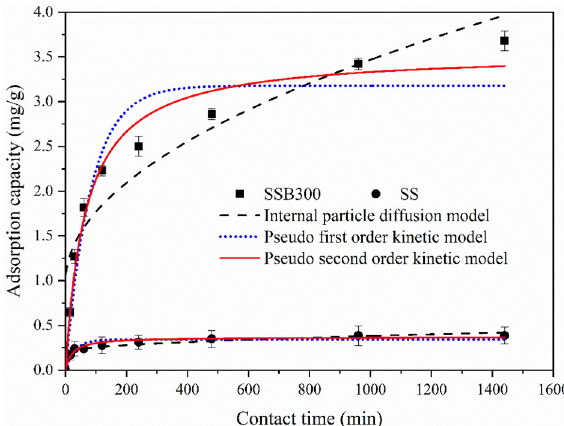
Figure 6. Ammonium adsorption kinetics fitting curve.